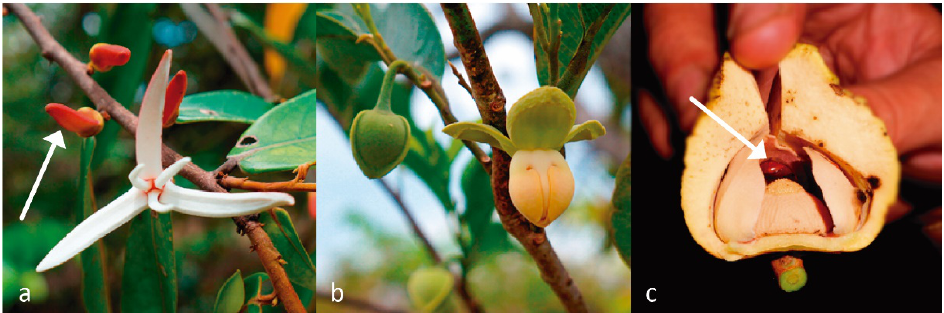
Figure 2. Flowers of three species of cantharophilous Annonaceae from our studies in the Cerrado of the Chapada dos Guimarães, MT, Brazil. Note that all three have light-colored perianths. ( a ) Xylopia aromatica has a mixed pollination system in which both thrips (Thysanoptera) and beetles (Coleoptera) take part. Flower visitation occurs mostly during the day, although flowers remain anthetic throughout the night. The adaxial surface of the outer petals and the linear inner petals are white. The abaxial surface of the outer petals, however, is of a vivid hue of red (arrow). ( b ) The calyx of Cardiopetalum calophyllum is light green, and the petals are light yellow. Flower visitation by nitidulids is diuturnal. ( c ) In this figure, it is possible to visualize the floral chamber of Annona crassiflora , delimited by the light yellow corolla. Pollinated by large nocturnal Cyclocephala scarabs (arrow), this species has large, thermogenic floral chambers. Note that the beetle shown inside has its head positioned toward the base of the inner petals, where the nutritious tissue patch is located.